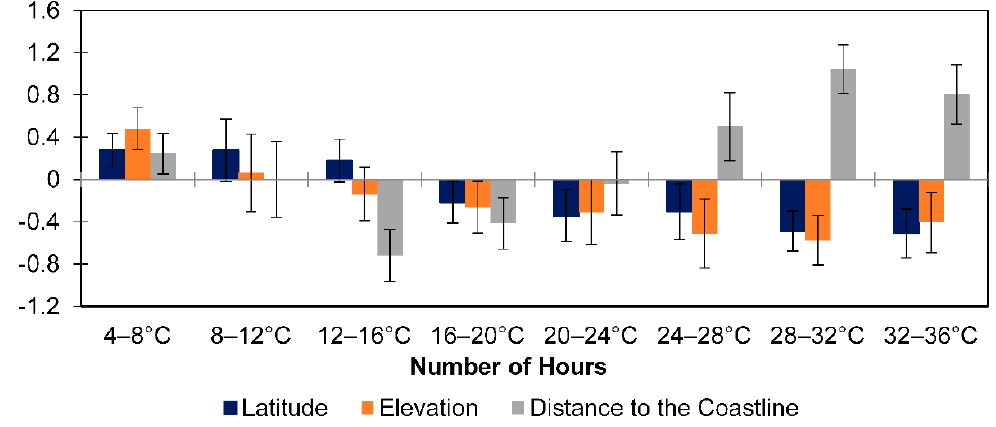
Figure 3. Multivariate linear regression coefficients of the three selected regressors (latitude, elevation, and distance to coastline), along with their corresponding 95% confidence intervals.